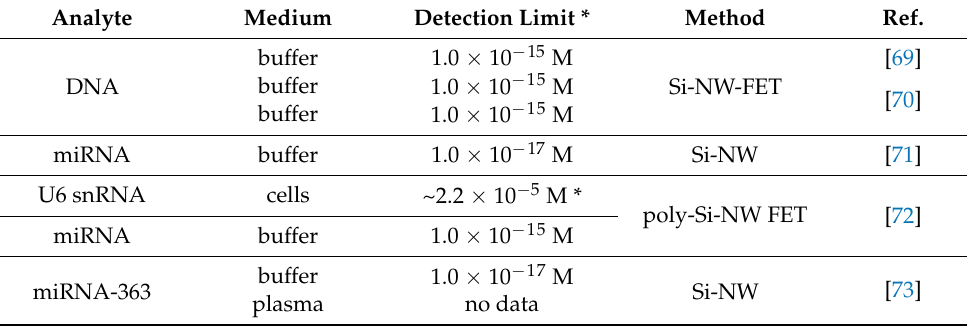
Table 2. Detection of nucleic acids, using nanowire silicon